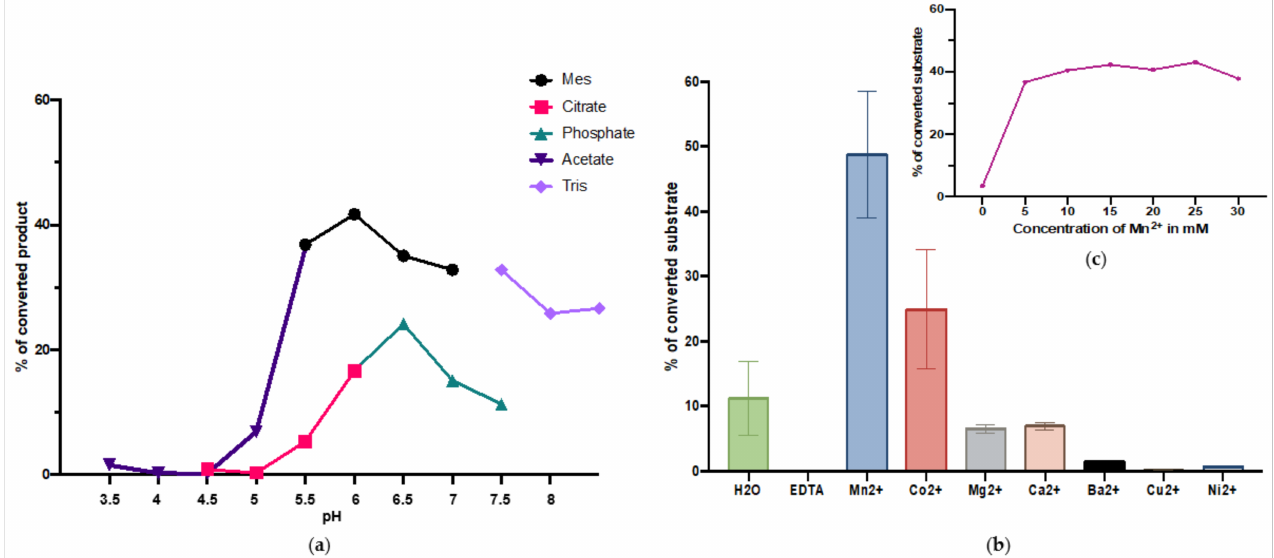
Figure 3. Biochemical properties of the recombinant T-synthase ( a ) Effects of different buffers and pH on the activity; ( b ) Influence of divalent cations on the enzyme activity; ( c ) Manganese concentration